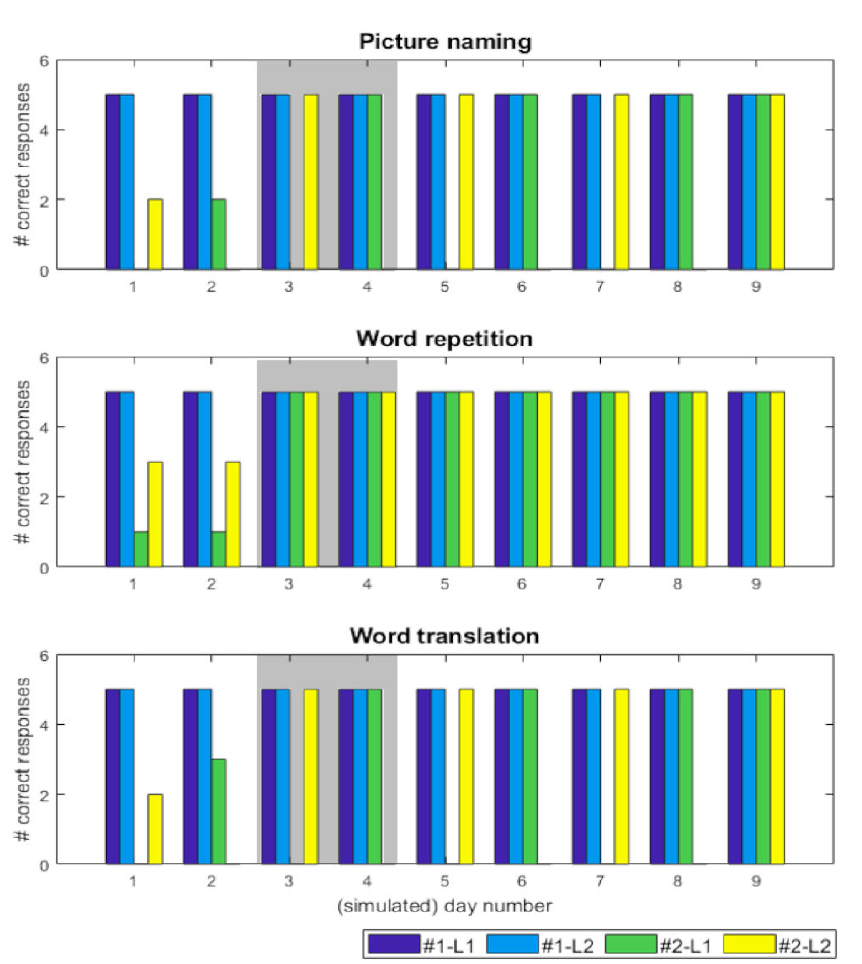
Figure 4. (simulated behavioural performance) The bar charts report the number of correct responses, for each task, across the 9 simulated days for two simulated subjects. Here, #1 is a control subject (dark and light blue bars) and #2 is a lesioned subject (green and yellow bars). The language (L1 / L2) in the legend denotes the speaker language e.g., for #1-L1 the subject was asked to repeat the word in L1 but translate the word from L1 to L2. Similarly, for #2-L2 the object had to be named in L2 but translated from L2 to L1 during the translation task. The x-axis is the simulated day number and the y-axis denotes the number of correct responses. The maximum number of correct responses, for each task per day, is 5. Day 3 and 4, in the grey box, is highlighted, the pattern of alternate antagonism and paradoxical translation in subject #2, e.g., when L2 is accessible (yellow bars; day 3), the subject is unable to name pictures and translate from L1 but can repeat in both L2 and L1. However, day 4 shows an alternate recovery profile: L1 is accessible (green bars), the subject is unable to name pictures and translate from L2 but can repeat in both L2 and